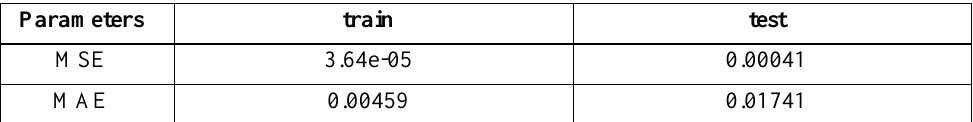
Figure 5. LSTM predictions using the test dataset Table 2. Results of the LSTM model